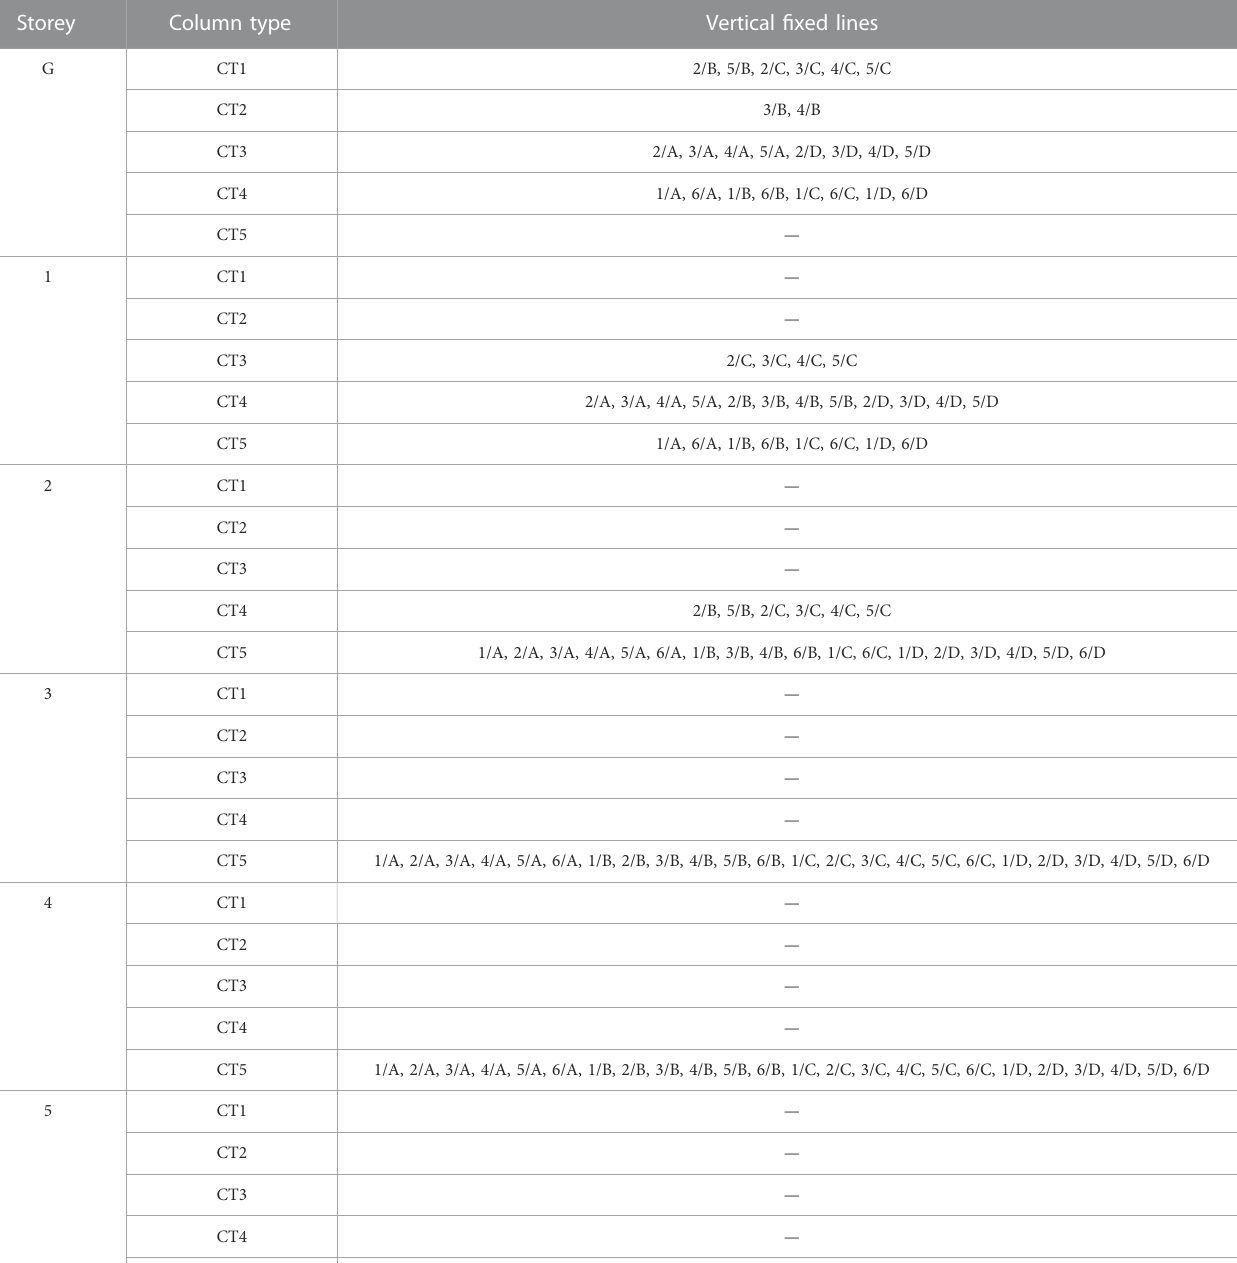
TABLE 1 Column sections. Storey Column type Vertical fi xed lines